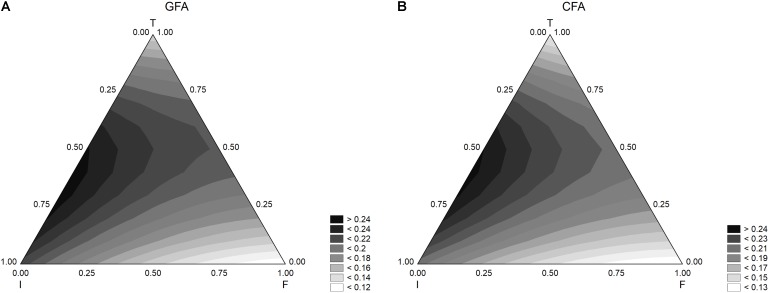
Triangular surfaces for the effect of flour (F), inoculum (I), and temperature (T) on the acidification rate (parameter dmax) by L. acidophilus. (A) GFA, design with gluten friendly flour; (B) CFA, design with control flour.